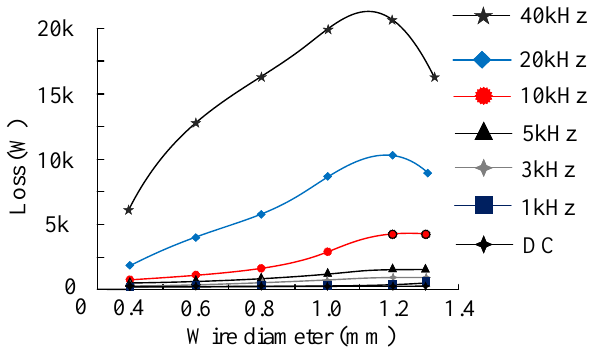
Figure 10. Winding losses at different frequencies and different wire